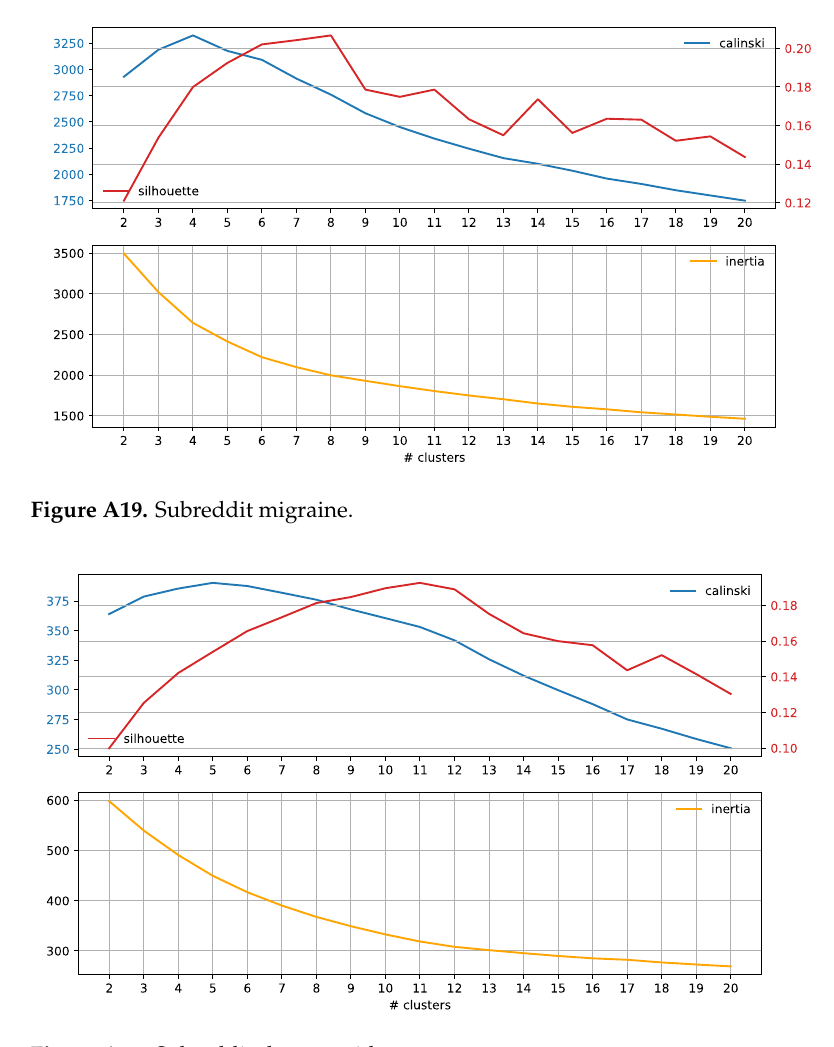
Figure A20. Subreddit rheumatoid.